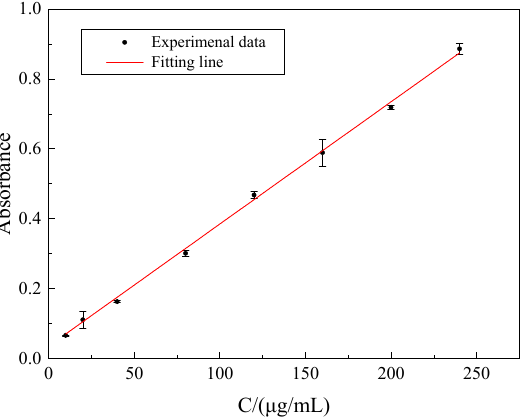
Figure 3. Standard curve of the absorbance–concentration of welan gum solution.